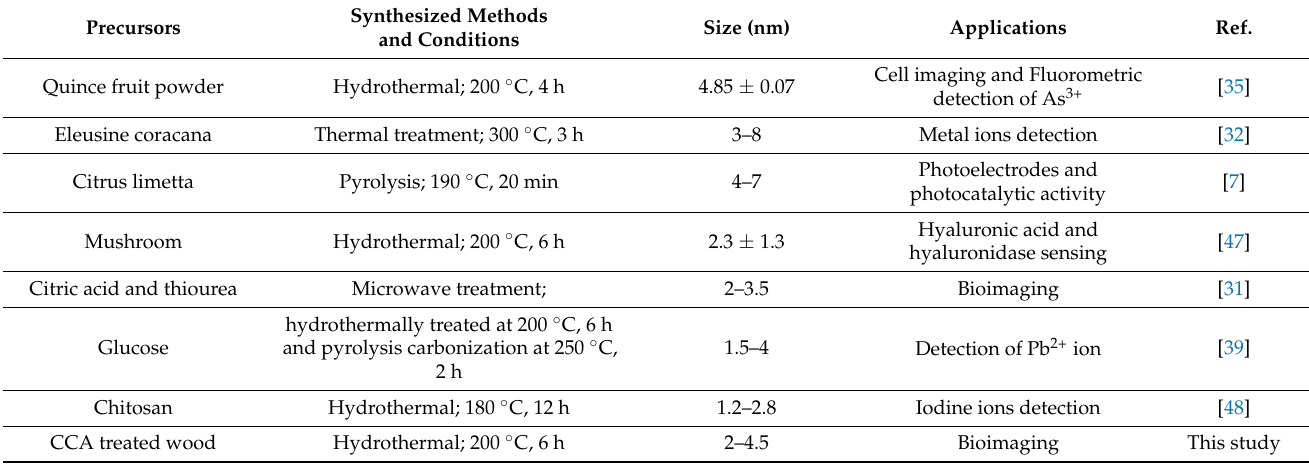
Table 1. Carbon dot synthesis from different precursors and their bio-applications.